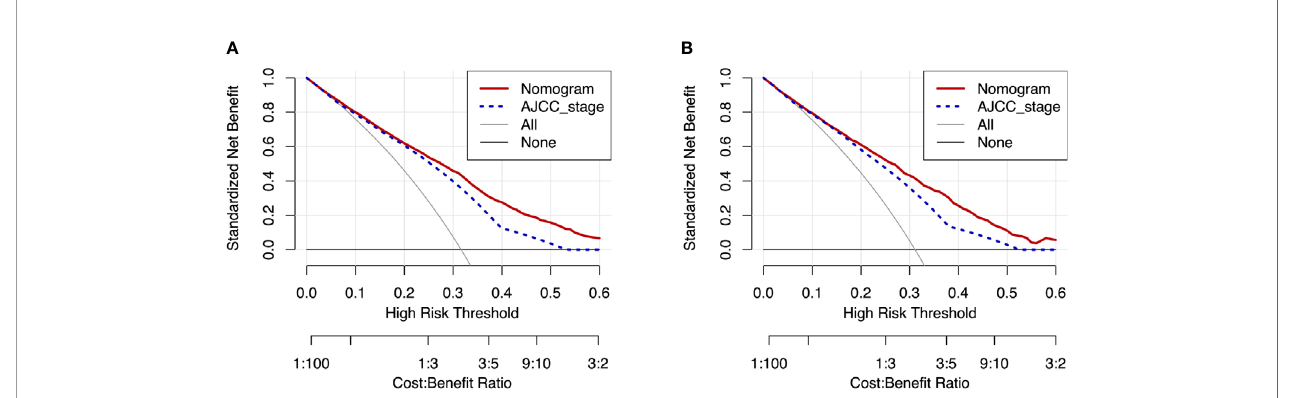
FIGURE 6 | DCA curves of the nomogram and AJCC stage for CSS in the training and validation cohorts. DCA curves of the nomogram and AJCC stage for CSS in both the training cohort (A) and validation cohort (B) . DCA, decision curve analysis; AJCC, American Joint Commission on Cancer; CSS, cancer-speci fi c survival.